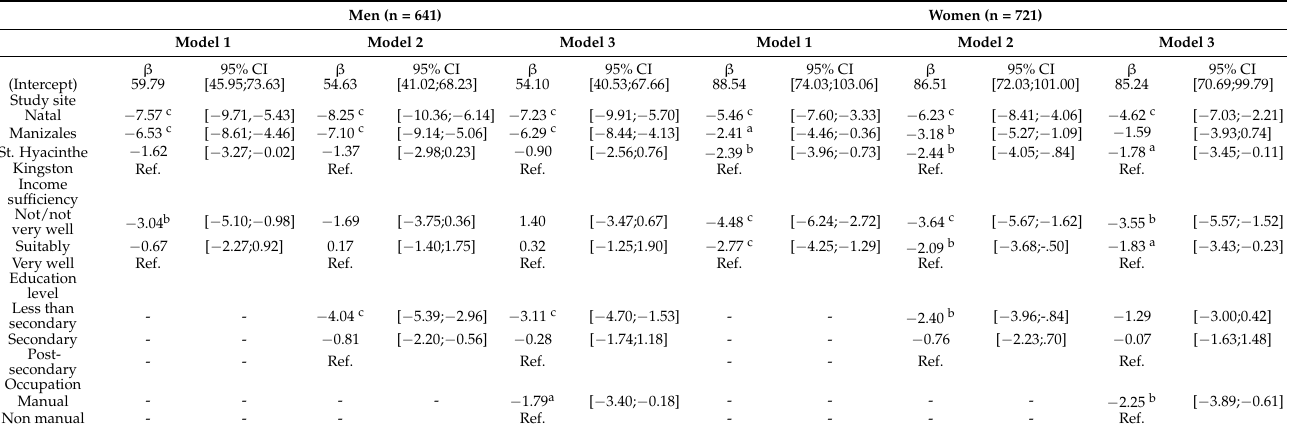
Table 3. Multivariate regression models assessing the influence of socioeconomic variables on the frequency subscale separated by gender.